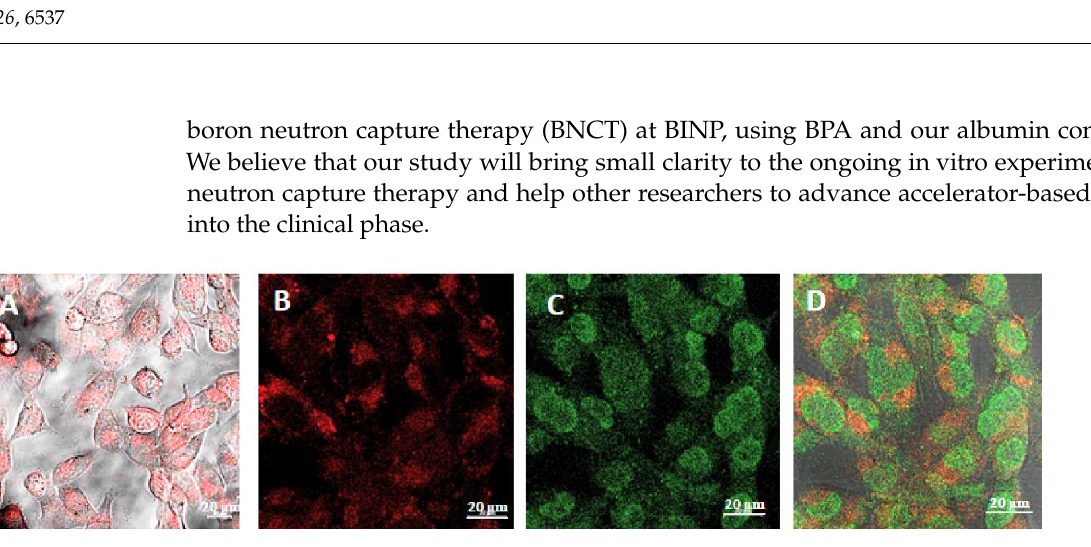
Figure 4. In vitro cellular uptake of HSA-Cy5-HcyTFAc-B 12 H 11 by T98G cells measured by flow cytometry. Red color: FACS analysis; green color: percent cellular uptake of HSA-Cy5 and HSA-Cy5-HcyTFAc-B 12 H 11 . The data were normalized to nontreated cells (control).